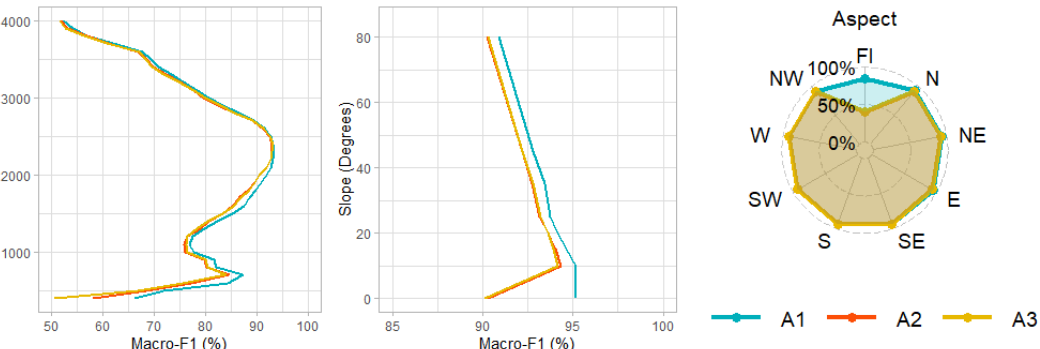
Figure 6 . Macro-F1 score of the predicted snow cover maps according to elevation ( left plot ), slope ( middle plot ) and aspect ( right plot ). A2 (red) and A3 (yellow) are almost coincident in the three graphs. (Fl = Flat, N = North, NE = North-East, E = East, SE = South-East, S = South, SW = South-West, W = West, NW = North-West).